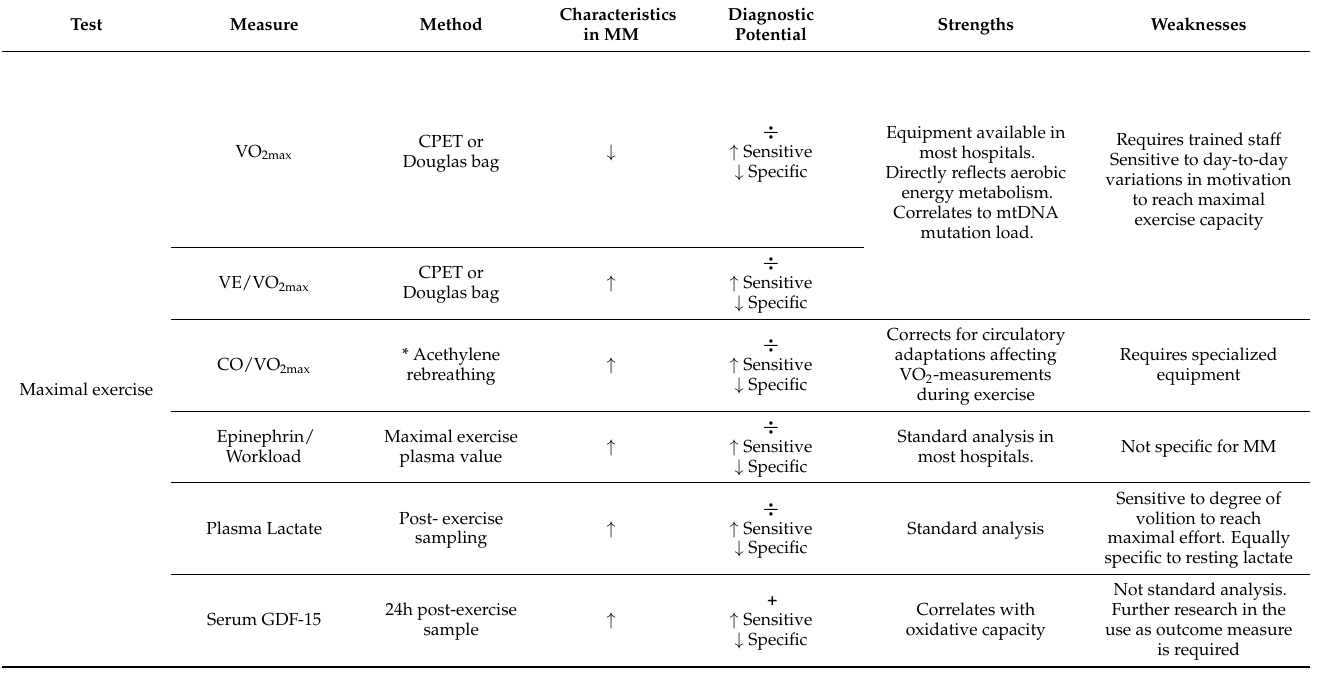
Table 1. Summary of the exercise tests and their characteristics in patients with Mitochondrial Myopathy (MM) and their potential as diagnostic tools or as outcome measures in clinical